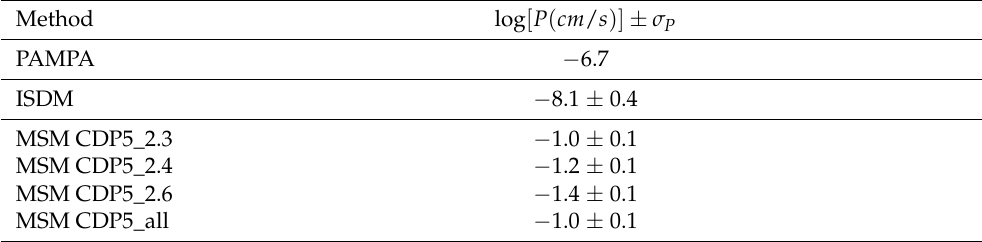
Table 1. Membrane permeability coefficient results for the cyclic decapeptide CDP5. PAMPA value was taken from